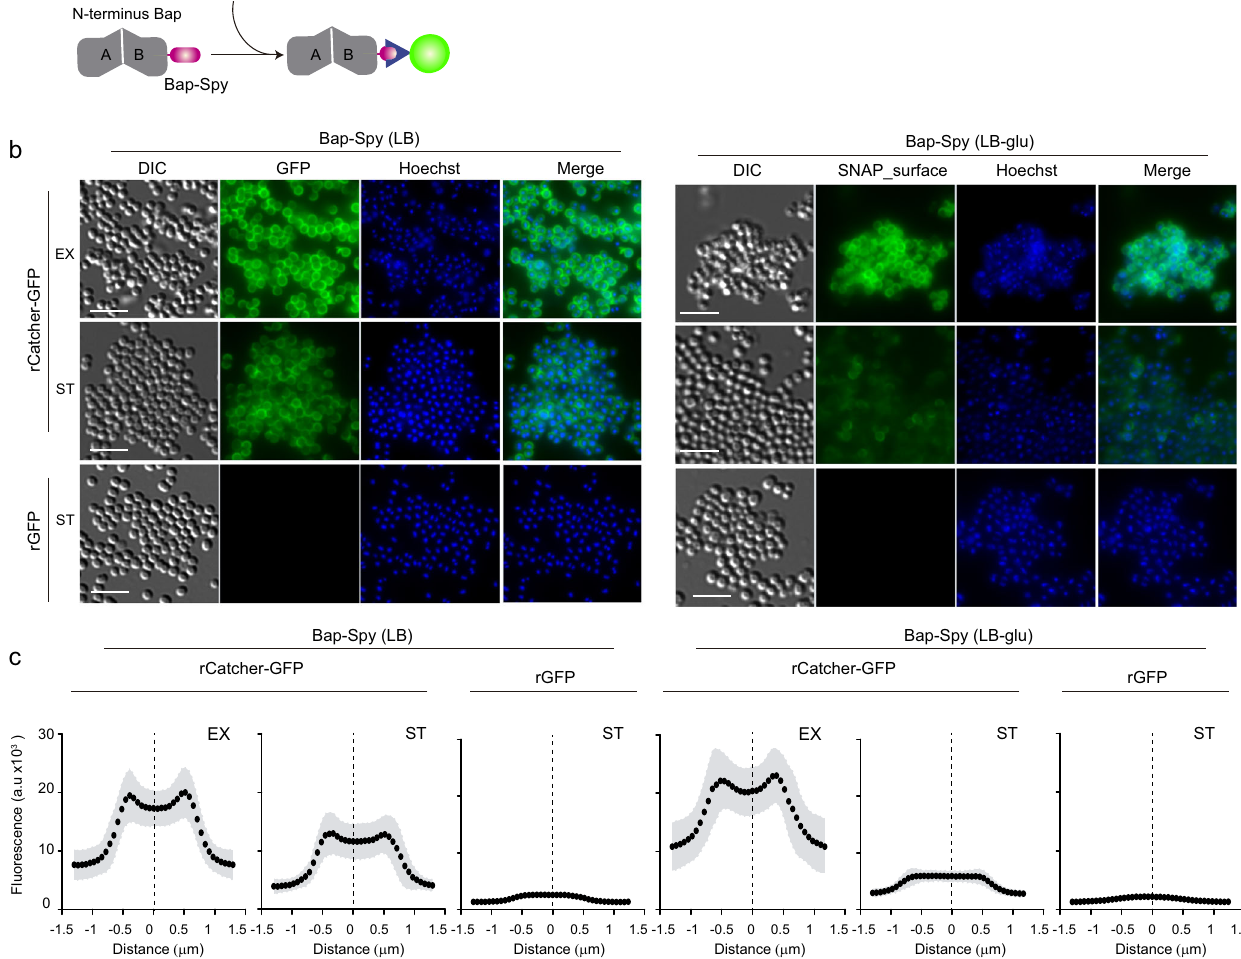
Fig. 5 SpyTag/SpyCatcher system can be used to generate a versatile tool for functionalized surface-displayed bacteria or Bap amyloid- like fi bers. a Schematic representation of Bap-Spy/rCatcher-GFP labelling mechanism. When the protein partner SpyCatcher fused to GFP is added, a covalent bond is formed between Bap-Spy and rCatcher-GFP resulting in fl uorescent labeling of Bap. b Fluorescence images showing localization of Bap in S. aureus Bap-Spy grown in LB and LB-glu media at 37 °C, 200 rpm until exponential phase (EX) (OD = 0.5) and stationary phase (ST) (OD = 5). Cells were probed with puri fi ed recombinant rCatcher-GFP and puri fi ed rGFP alone (used as a control) followed by nucleic-acid stain Hoechst. The fl uorescence of GFP and Hoechst, the combination of both signals (merge panels) and the differential interference contrast (DIC) images are shown. Scale bar of panels represents 5 μ m. c Graphs correspond to the mean of the intensity pro fi les of cross-sections cells ( n ~30). Gray shadow corresponds to standard deviation of the plasmid-complemented expression, but no external recombinant TasA was used 9,35 . Here we produced recombinantly the amyloidogenic region of Bap with the SpyTag peptide. Exogenous complementation of Gram-positive bacteria with an engineered B-region of Bap promoted a multicellular behaviour phenotype (Fig. 8). The use of non-genetically modi fi ed functionalized bacteria can be considered as the main advantage of this technology for its use as a therapeutic tool. In short, taking advantage of Bap externalization as an adhesin and polymerization into amyloid-like fi bers, we can secrete a wide variety of Bap-peptide constructs that will be part of the extracellular matrix. The use of facultative amyloids as an immobilization tool in bio fi lms has several bene fi ts. Bacteria can be engineered to produce functional domains and manipulate the transition from the adhesin conformation to amyloid conforma- tion by controlling parameters such as temperature and pH. Under